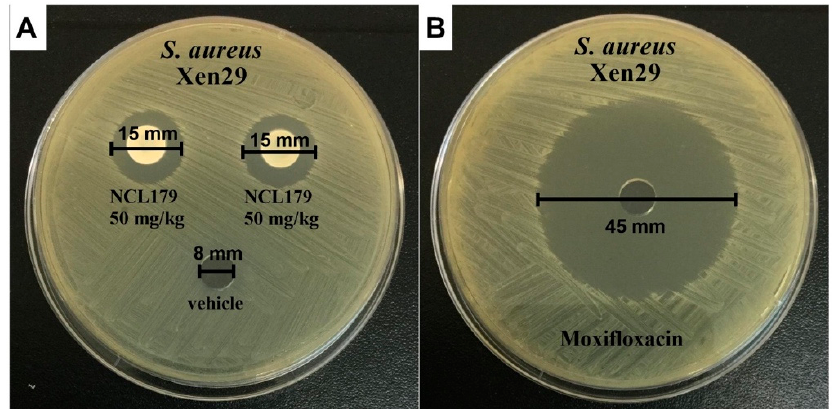
Figure 5. Selected well diffusion of NCL179 used in the efficacy trial. ( A ), to each well, 30 µL of either NCL179 formulation or vehicle only was added; ( B ), 30 µL of moxifloxacin (BovaVet, Caringbah, NSW, Australia). Concentrations of NCL179 in formulations were prepared as a 50 mg/mL solution to achieve 50 mg/kg in mice (30 g); moxifloxacin is a drug control and was prepared as a 6 mg/mL solution to achieve 6 mg/kg in mice (30 g); Xen29, S. aureus Xen29.